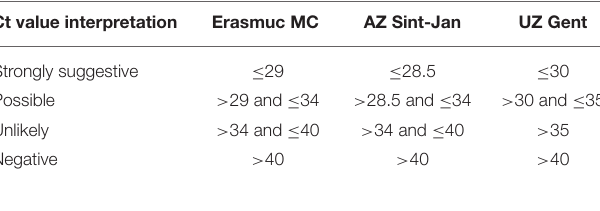
TABLE 1 | Interpretation of Ct value in each of the 3 centers regarding likelihood of PCP.